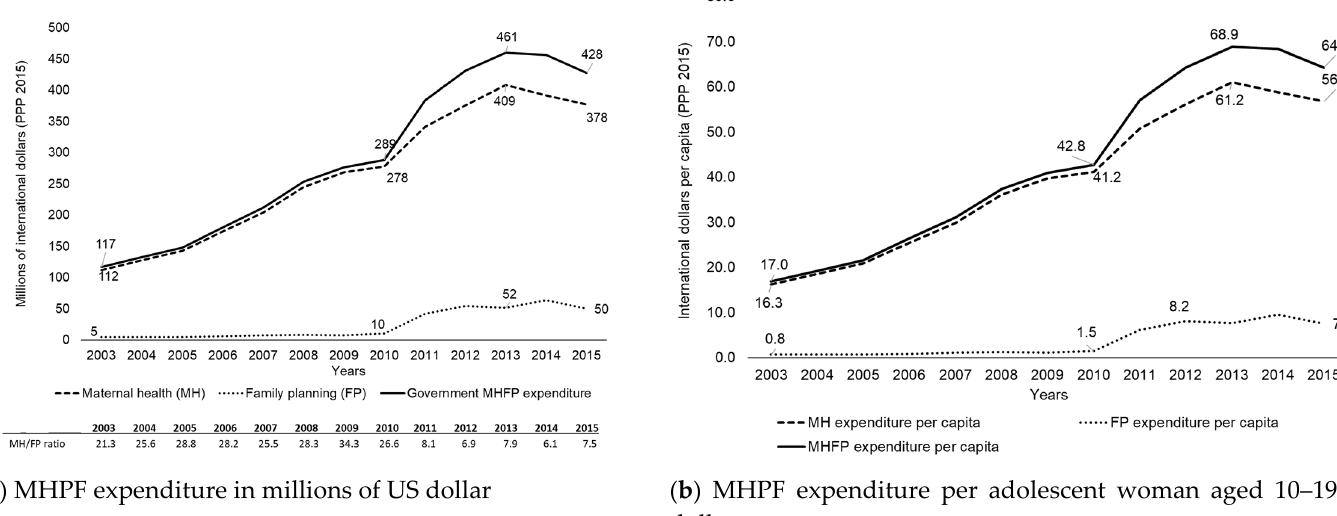
Figure 1. Government Maternal Health and Family Planning (MHFP) expenditure for adolescents aged 10–19 without Social Security coverage, Mexico, 2003–2015, US$ (PPP 2015). Table 1. Average annual percent change in government Maternal Health and Family Planning (MHFP) expenditure for the entire adolescent population aged 10– 19 without Social Security coverage, Mexico, 2003–2015.